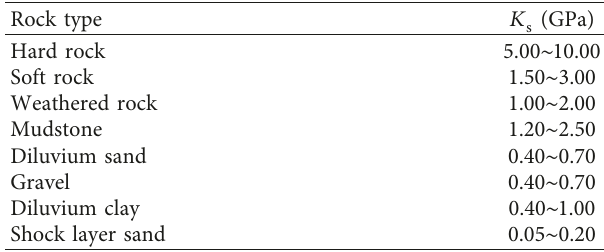
Figure 4: Coordination deformation between the anchor and surrounding rock [29]. Table 1: K s for different rocks